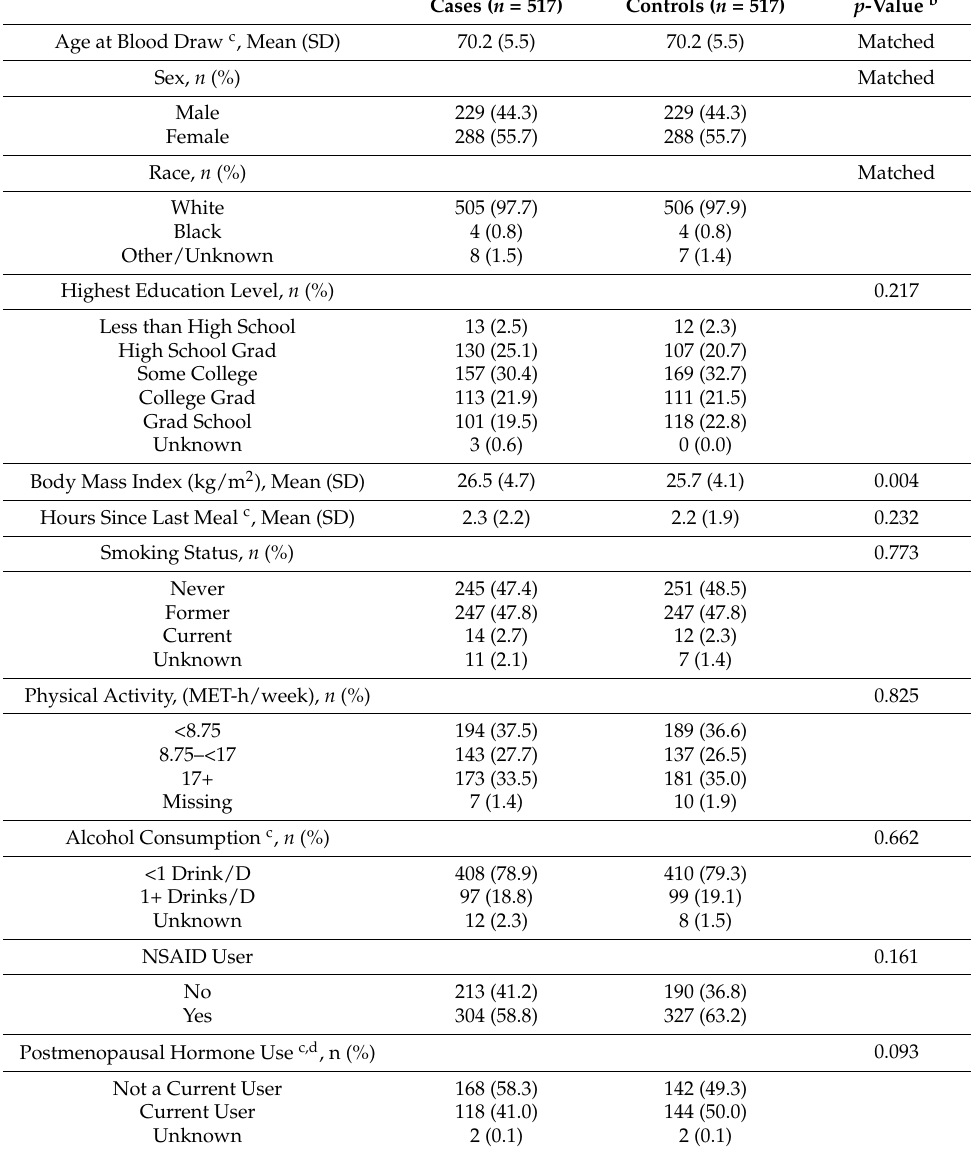
Table 1. Participant characteristics of a nested, matched a case–control study in the Cancer Prevention Study-II Nutrition